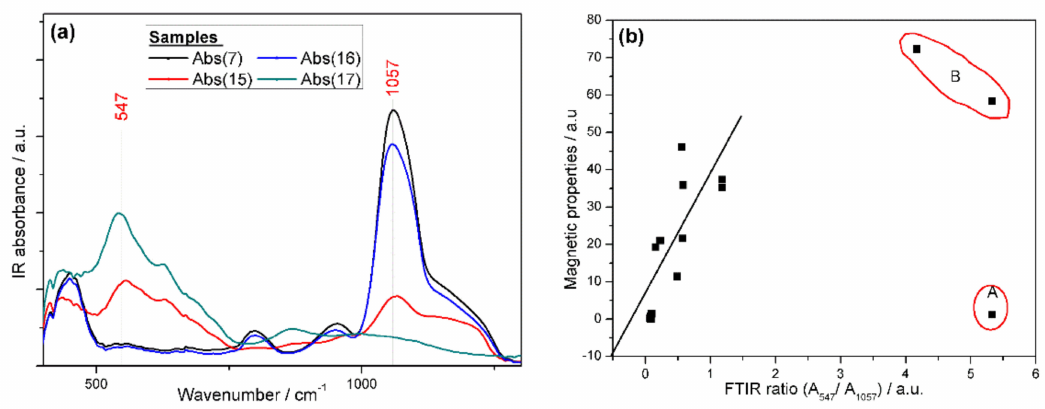
Figure 8. ( a ) The FTIR spectra of selected magnetic nanoparticles (mNPs) depending on its color; ( b ) relation between FTIR ratio (A 547 / A 1057 ) and magnetic properties for the prepared